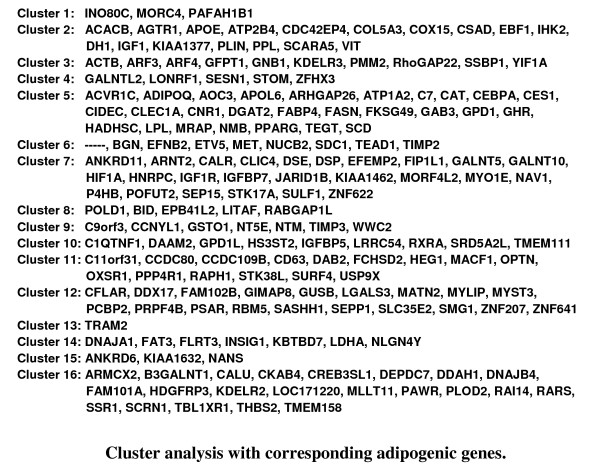
Cluster analysis with corresponding adipogenic genes. The number and names of the corresponding Cluster genes are listed in Figure 8. It became possible to observe the expression profiles of different cluster genes (known or unknown for adipogenesis) and to find further early and late stage adipogenesis marker genes with similar qualities. Detailed mean signal values of human MSC at day 0, 1, 3, 7, 17 and of native fat tissue are also given in Additional files 1 and 2.